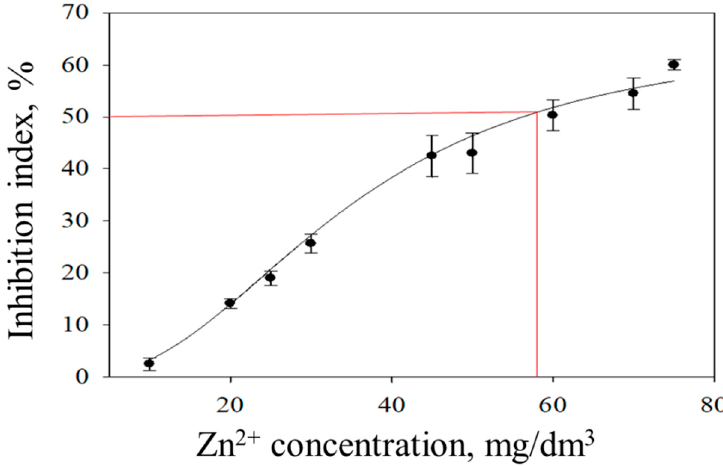
Figure 4. Inhibition curve for a bioelectrode based on the mediator ferrocene and bacteria P. yeei . Red line is IC 50 value for the Zn 2+ toxicant.